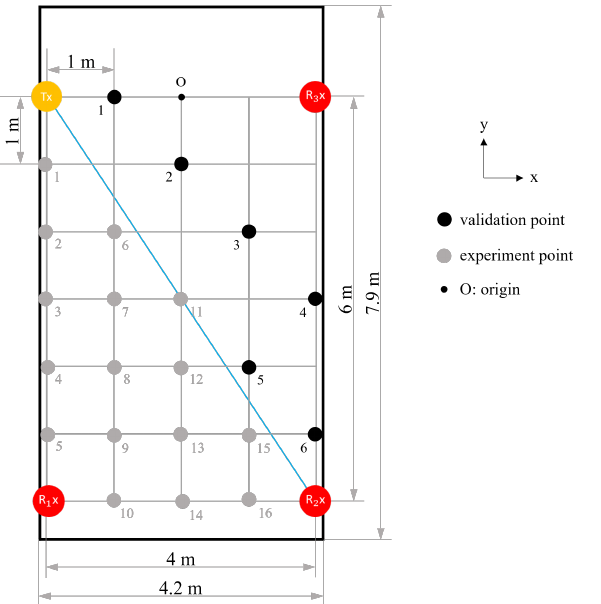
Figure 6. Experimental deployment for detecting the resting tremor using a transmitter paired with multiple